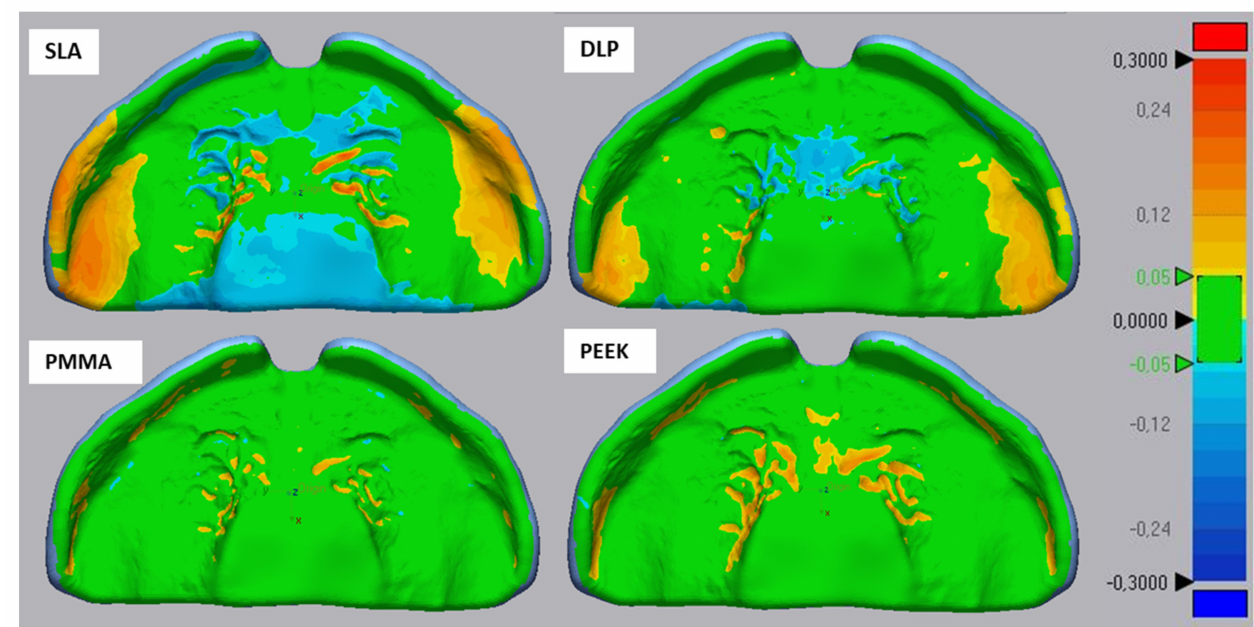
Figure 9. Exemplary trueness color maps of both AM technologies and materials (Dental LT Clear for SLA; V-Print Splint for DLP), as well as the two SM materials (Yamahachi PMMA and Smile PEEK) are displayed. The color maps display a critical deviation of ± 300 µ m and a nominal deviation of ± 50 µ m (color range in